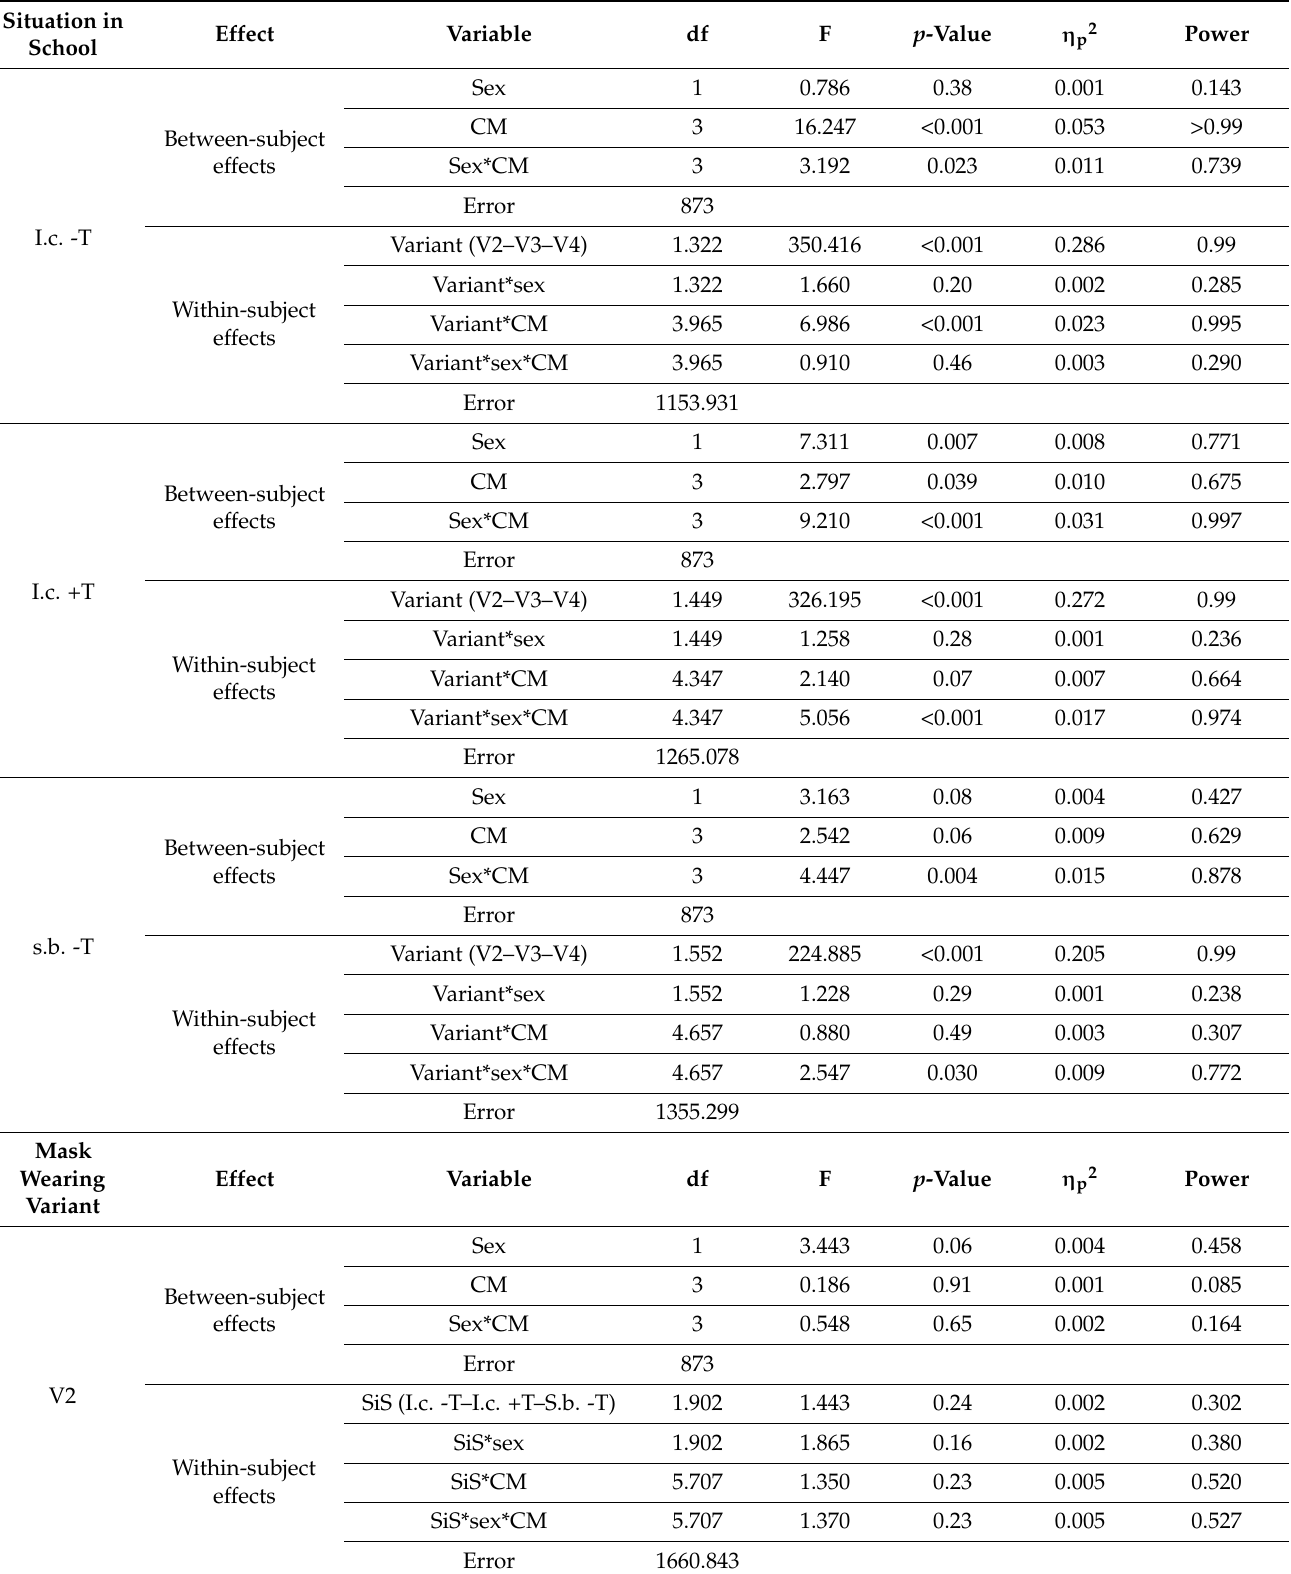
Table 3. ANOVAs for incorrect mask wearing (situations in the schools and mask wearing